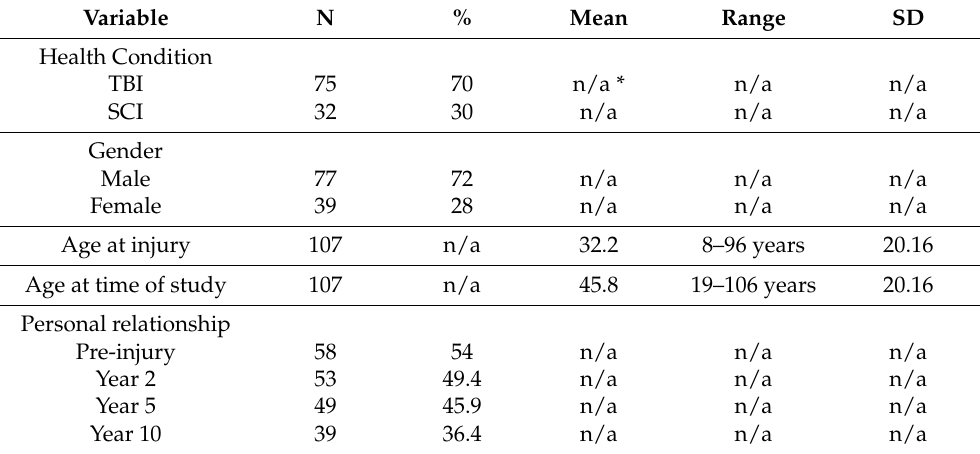
Table 2. Key study cohort context